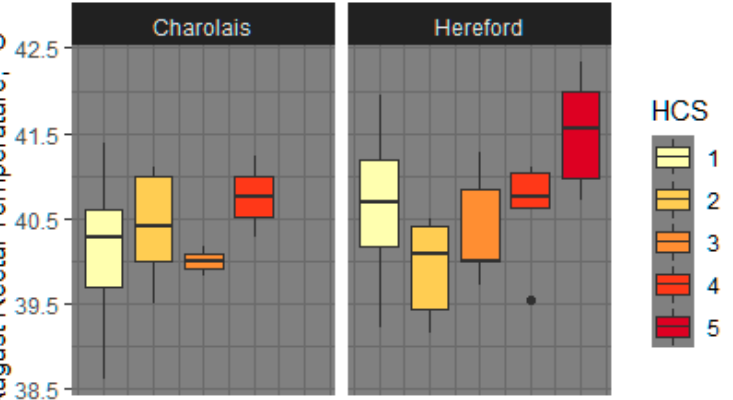
Figure 2. August cow rectal temperatures increase as hair coat score (HCS) increases and differ by sire breed. August HCS ( p < 0.004) and sire breed (Charolais or Hereford) were found to have sig- nificant ( p < 0.004) effects on August rectal temperature when analyzed independently of fescue exposure type. Effect of August HCS was seen in comparison of rectal temperatures for cows with an August HCS of 5 to those with HCS 1, 2 or 3.